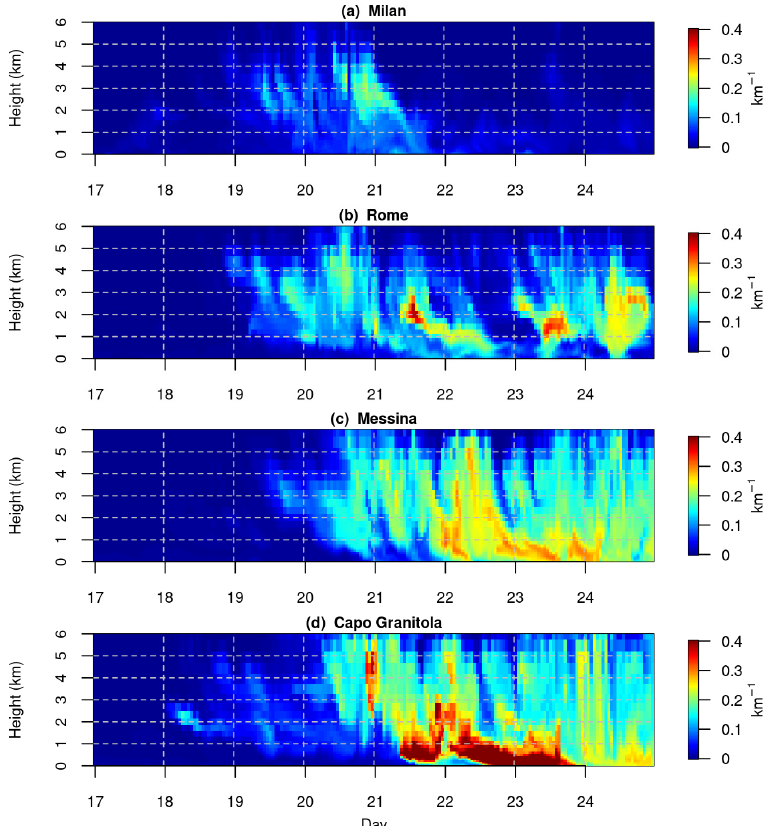
Figure 10. Continuous (h24) time series of the extinction coefficient at 0.55 μ m (units km − 1 ) modeled by WRF-Chem for the period of 17–24 June 2021 ( x -axis) by the FULL coupled configuration for ( a ) Milan, ( b ) Rome, ( c ) Messina and ( d ) Capo Granitola.